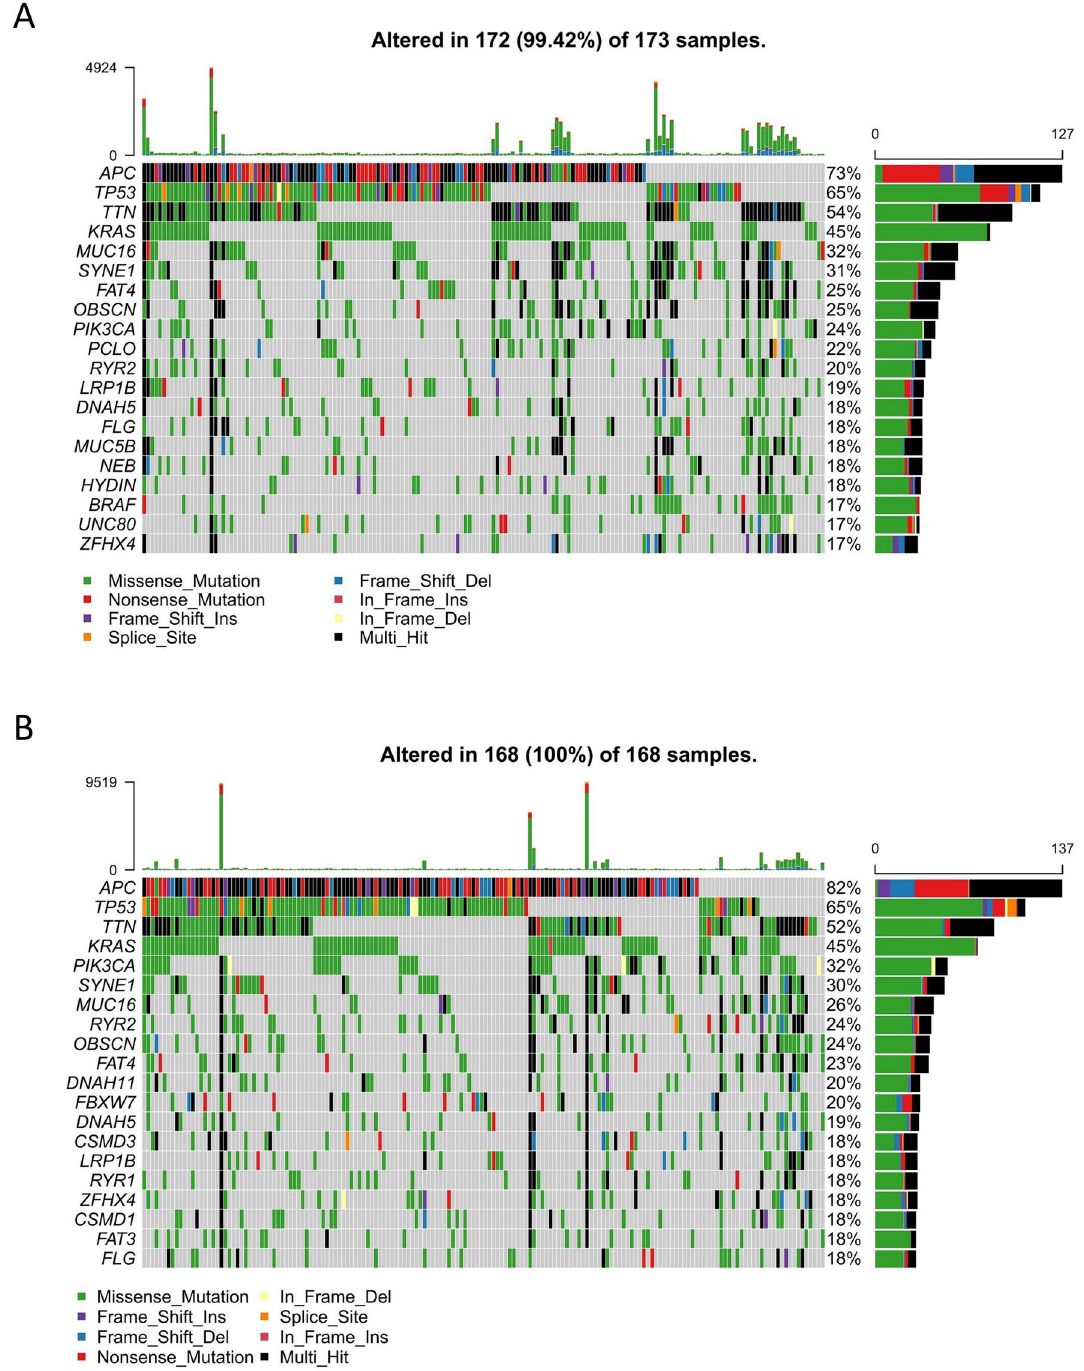
Figure 8. Mutation landscape of the prognostic signature in TCGA cohort. Waterfall plots of frequently mutated genes in ( A ) high-risk and ( B ) low-risk